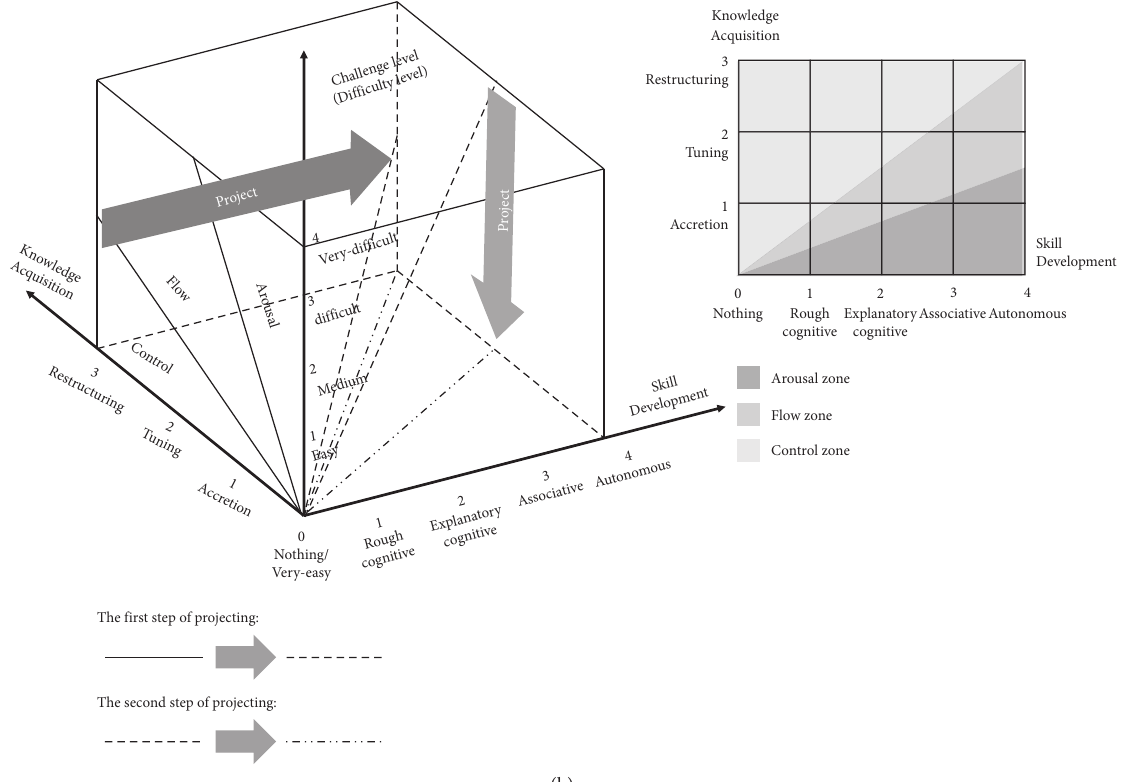
Figure 4: The integration of the Learner’s Growth Model and the dynamic flow state presenting the relation between skill development and challenge level (a) and the relation between knowledge acquisition and challenge level